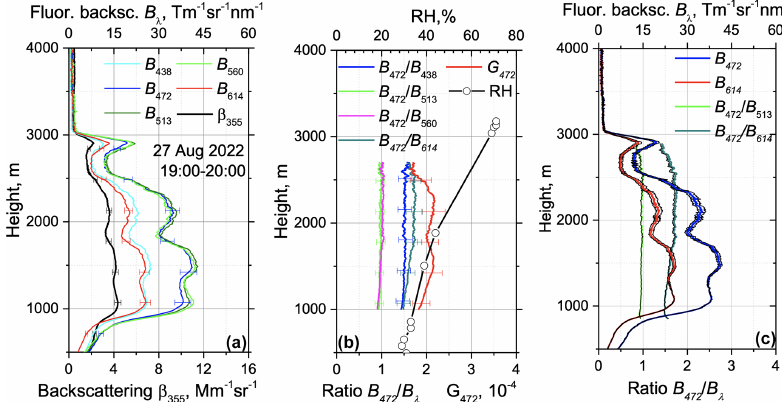
Figure 4. Observations on 27 August 2022 for the period 19:00–20:00UTC. (a) Fluorescence-spectral-backscattering coefficients B λ at 438, 472, 513, 560 and 614nm and the aerosol-backscattering coefficient β 355 . (b) The ratios B 472 /B 438 , B 472 /B 513 , B 472 /B 560 and B 472 /B 614 and the fluorescence capacity G 472 . Symbols show the relative humidity measured by a radiosonde at 00:00UTC on 28 August. (c) Fluorescence-spectral-backscattering coefficients B λ at 472 and 614nm wavelengths and the ratios B 472 /B 513 and B 472 /B 614 calculated for the Angstrom exponent values A = 0.5, 1 and 1.5. Results for A = 0.5 and A = 1.5 are shown with thin black lines; the increase of A decreases the B λ . The profiles in panels (a) and (b) are calculated for A =